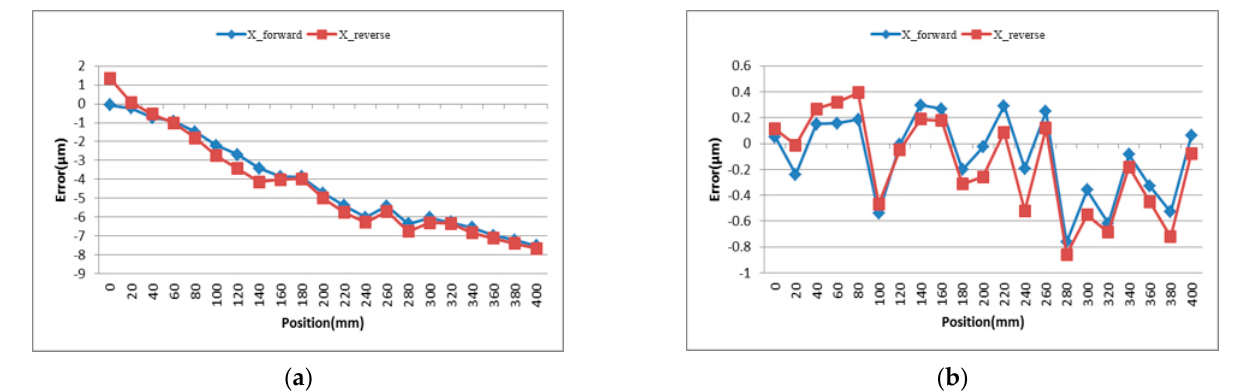
Figure 5. Compensation on the X -axis: ( a ) results before compensation and ( b ) results after compensation.